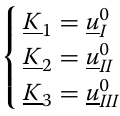
“Straightforward” singular enrichment